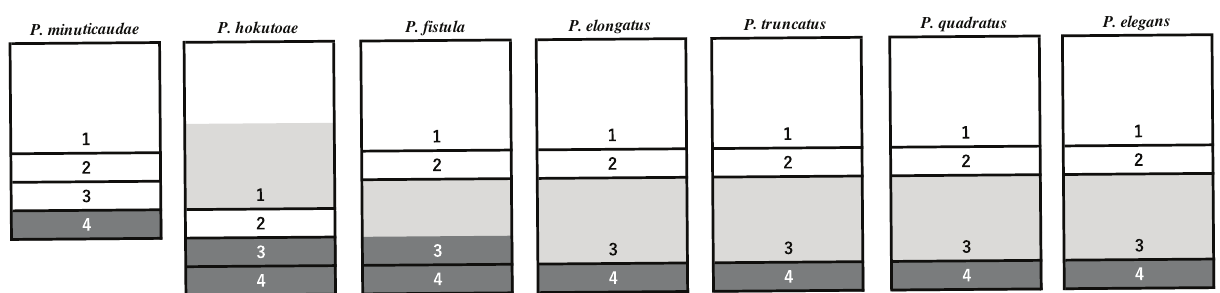
Figure 3. Schematic illustration of cephalothorax and pedigerous somites 1–4 of seven species of Peniculus . Numbers indicate relative positions of legs on pedigerous somites 1–4. Light gray: elongated part; dark gray: